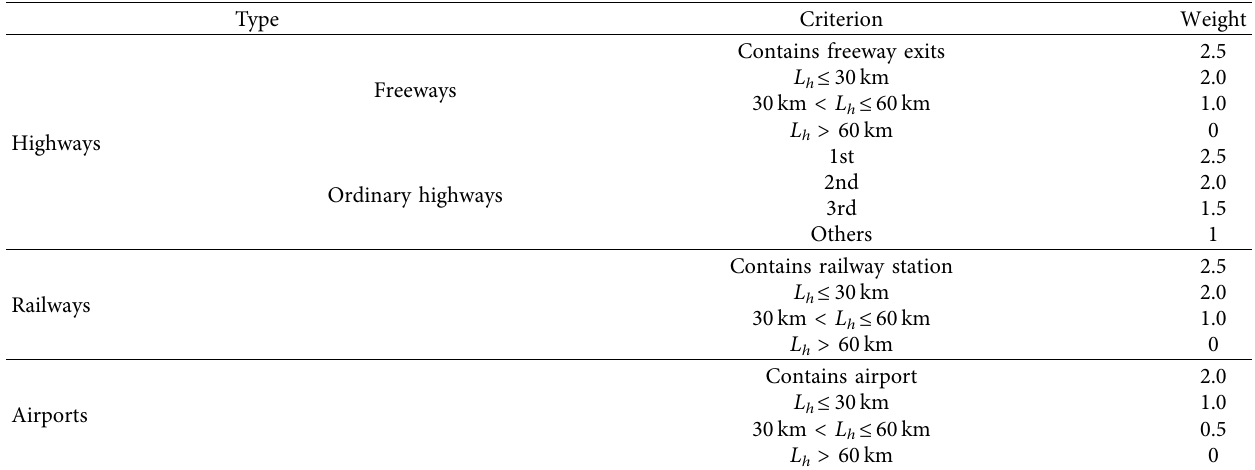
Table 1: The weight of transportation infrastructure with different